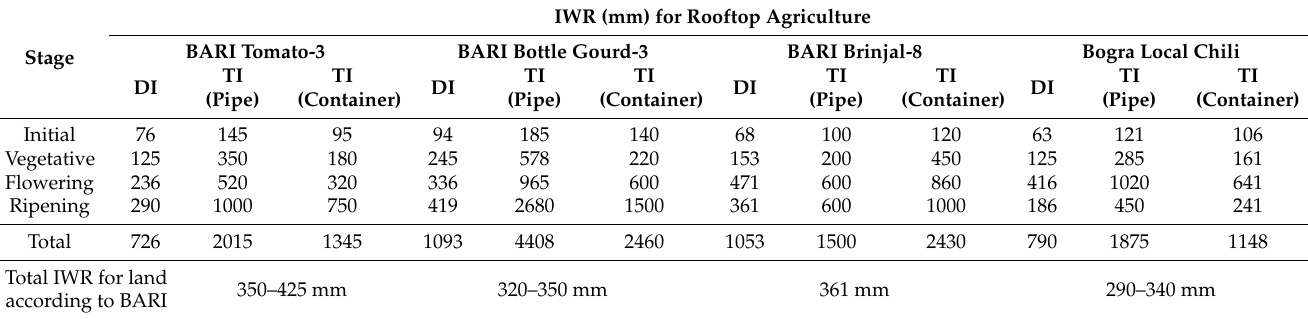
Table 6. Growth stages and irrigation water requirement (IWR) in